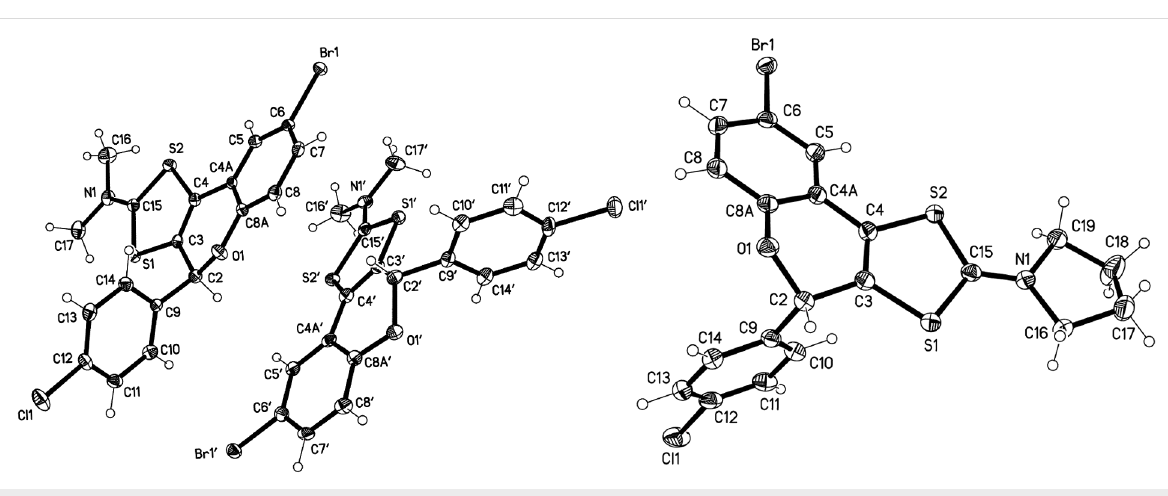
Figure 4: Molecular structure of 5a (left, both independent molecules) and 5b (right, one of two independent molecules). Ellipsoids represent 50% probability levels [26].